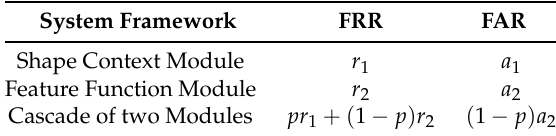
Table 3. FRR and FAR of individual verification modules and cascade